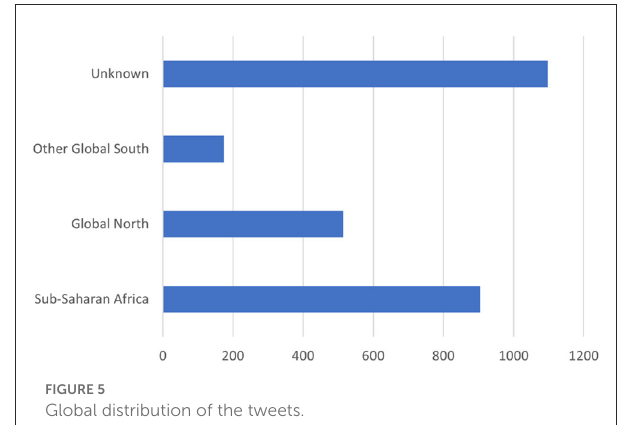
FIGURE5 Global distribution of the